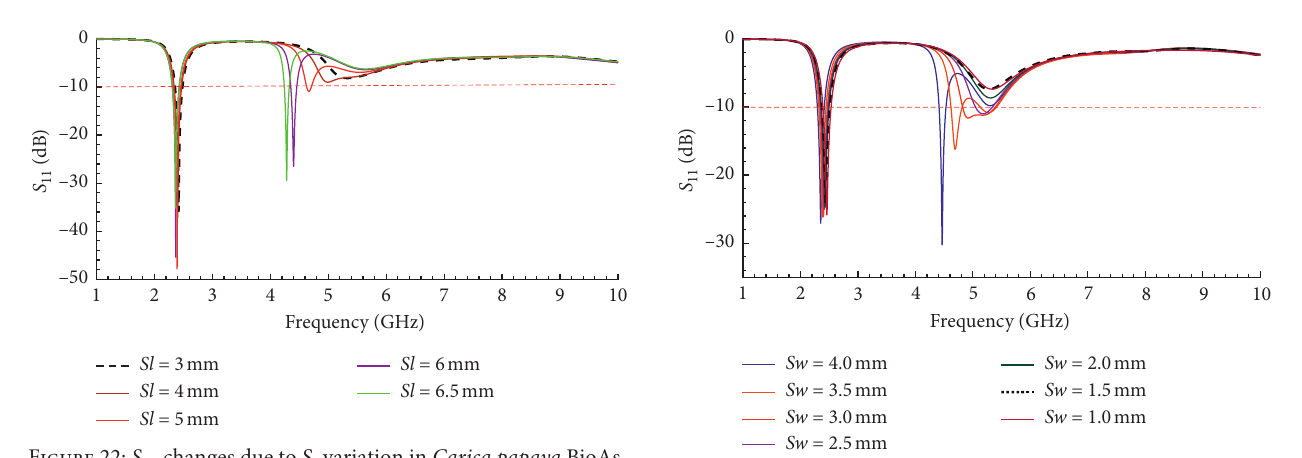
11 changes due to